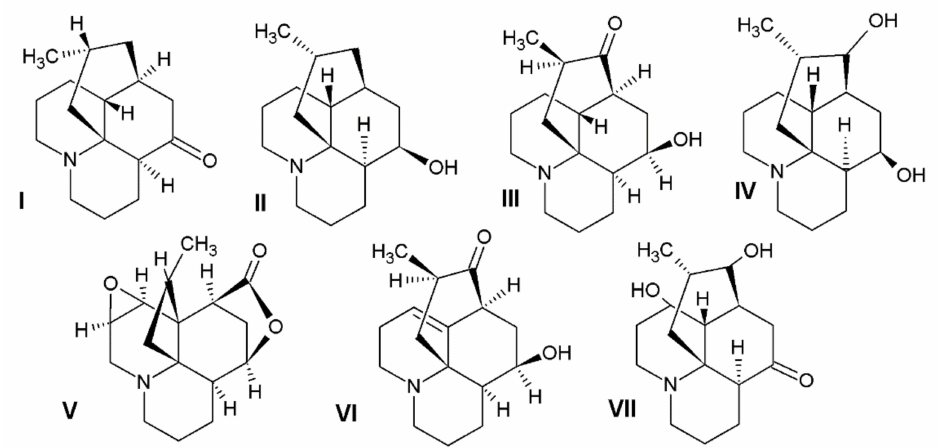
Figure 1. The chemical structures of the alkaloids detected in the investigated plant materials: I—lycopodine, II— dihydrolycopodine, III—annofoline, IV—deacetylfawcettine, V—annotinine, VI—acrifoline, VII—8- β ,11- α dihydroxy- lycopodine.